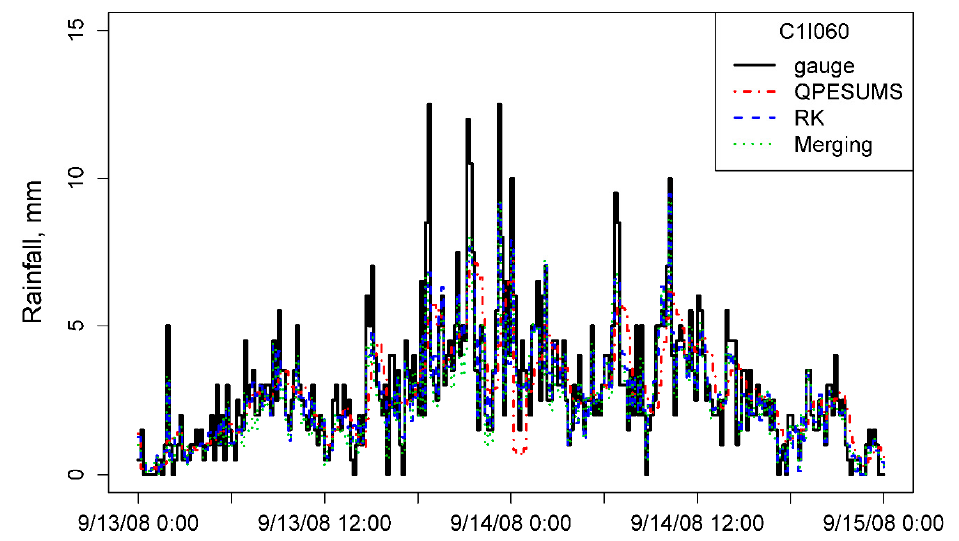
Figure 11. Hyetographs at station C1I060 showing the complete time variations in rainfall data from RK (adjusted), merging (adjusted), QPESUMS (unadjusted), and gauges for the event of Typhoon Sinlaku .